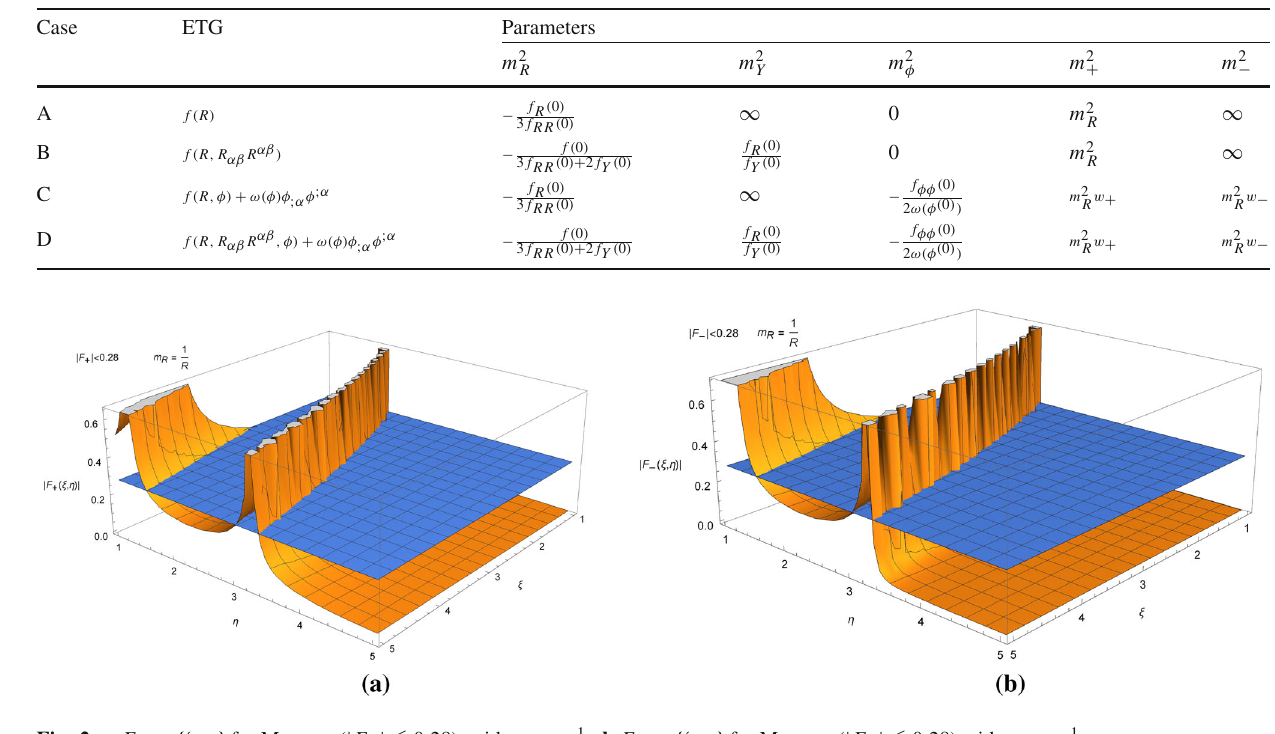
Fig. 2 a F + vs { ξ,η } for Mercury ( | F + | (cid:3) 0 . 28), with m R = 1 R . b F − vs { ξ,η } for Mercury ( | F − | (cid:3) 0 . 28) with m R = 1 R Table 2 Values of periastron advance for the first six planets of the Solar System. In the table we present the values of the eccentricity (cid:10) , semi-major axis a in meters, the orbital period P in years, the periastron advance predicted in General Relativity (GR)